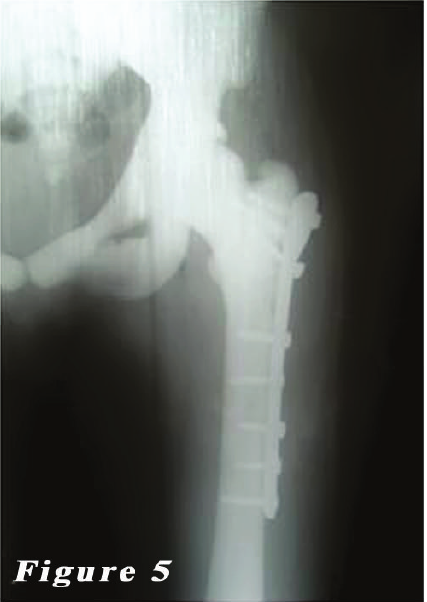
Figure 5: Postoperative left femur radiograph of the second